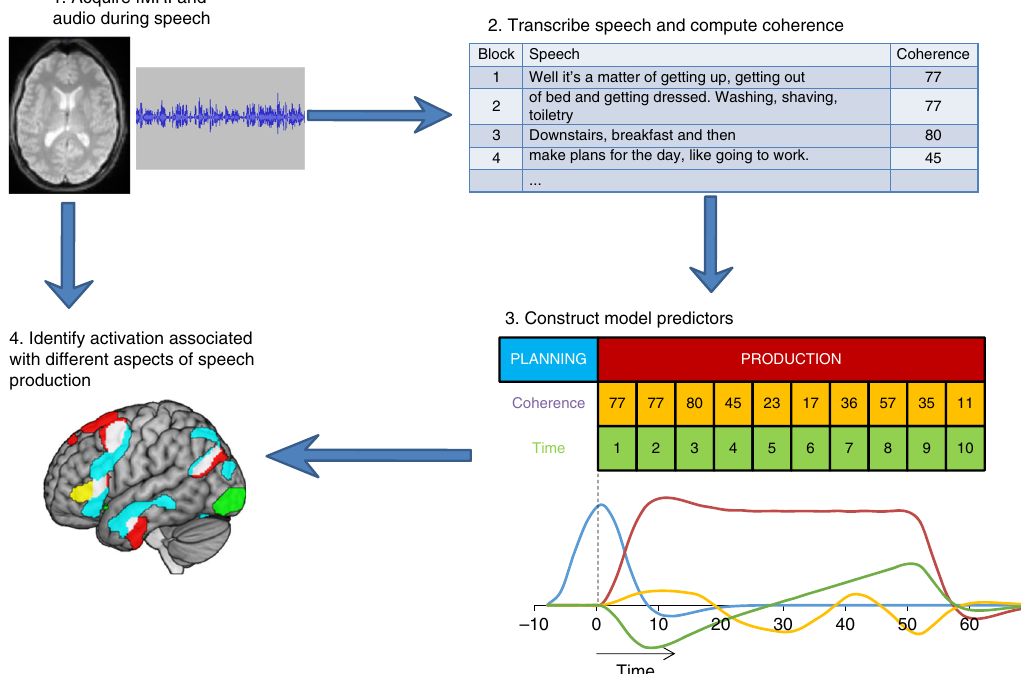
Fig. 1 Stages in data analysis. 1. Participants were recording while speaking in the scanner. 2. Speech was divided into blocks of 5 s, transcribed and analysed using computational linguistic techniques to provide an estimate of coherence for each 5 s block. 3. A general linear model was constructed with regressors tracking speech planning periods, speech production periods, activation correlated with coherence and activation changing over time. 4. The model was fi tted to voxel time-series in whole-brain and ROI